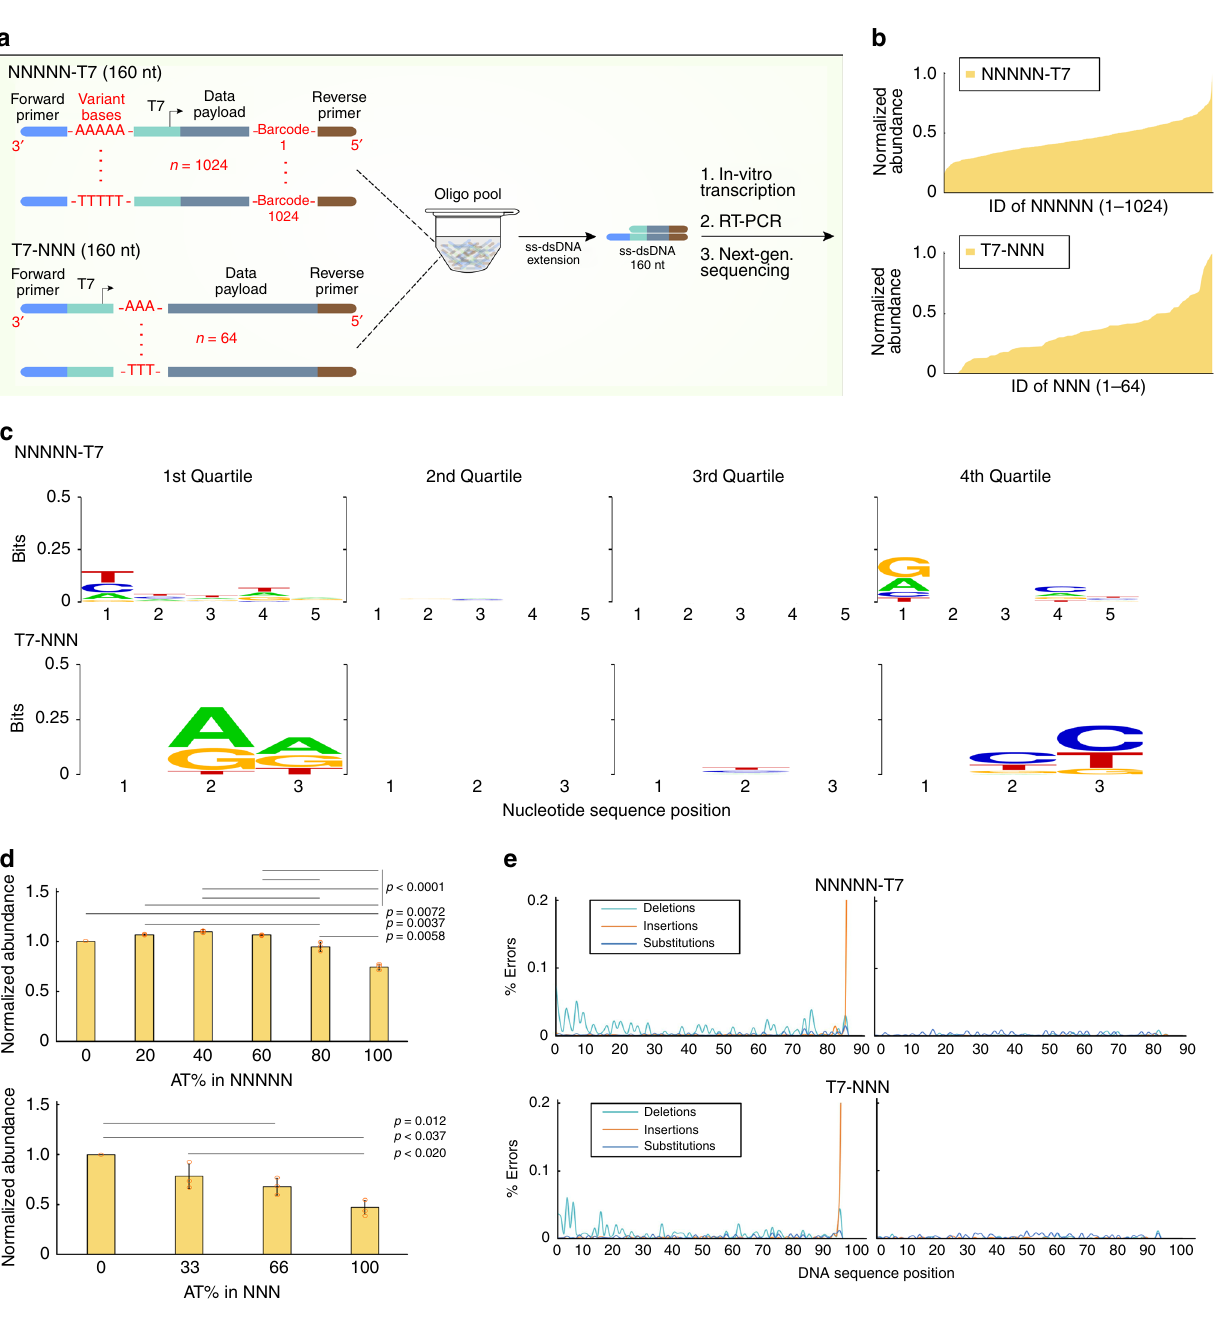
Fig. 5 T7-based transcription ef fi ciency can be controlled by surrounding sequences. a An oligo pool that had 1088 distinct sequences was designed to generate ss-dsDNA templates. The fi rst 1024 sequences contained all possible combinations of nucleotides upstream of the promoter sequence (NNNNN- T7, where N is one of four DNA nucleotides), whereas the latter 64 sequences had all possible combinations of nucleotides downstream to the promoter region (T7-NNN). Each sequence contained a barcode to identify the sequence of the variant nucleotides. The template ss-dsDNAs were processed with IVT for 8 h, followed by RT-PCR and next-generation sequencing ( n = 3 for each condition). b Transcription ef fi ciencies of both sequence designs were plotted by normalizing the read count of each transcribed strand to its abundance in the original library. The data was organized from lowest to highest normalized abundance for both designs. c The sequences were further divided into four quartiles based upon normalized transcript abundance and analyzed by the WebLogo tool. d The normalized abundance of each sequence was organized by A/T percentage. P values between each group were calculated using One-Way ANOVA with Tukey – Kramer post-hoc and listed here for statistical signi fi cance. NNNNN-T7: p values less than 0.01 for comparisons between 0% – 100%, 80% – 100% and 20% – 80%; p values less than 0.001 for comparisons between 20% – 100%, 40% – 80%, 40% – 100%, 60% – 80% and 60% – 100%; T7-NNN, p values less than 0.05 for comparisons between 33% – 100%, 0% – 100% and 0% – 66%. e The percent error for each DNA sequence position for the original synthesized database (left) and transcribed database (right). The error rate was calculated by dividing the number of errors of a given type occurring at a nucleotide position by the total number of reads for that sequence (Supplementary Method). Plotted values represent the arithmetic mean, and error bars represent the s.d., of three independent IVT-RT-PCR-NGS samples. Source data are provided as a Source Data fi